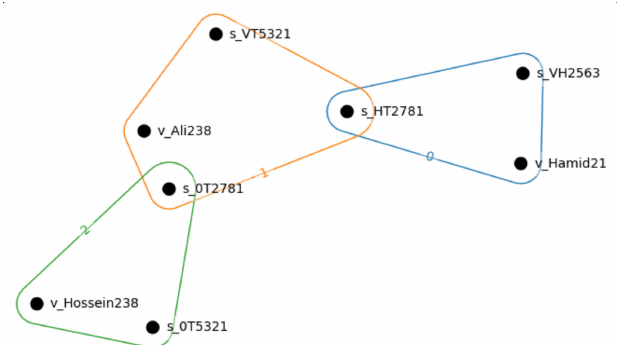
Figure 9. Hypergraph example of sensors and volunteers in the implemented